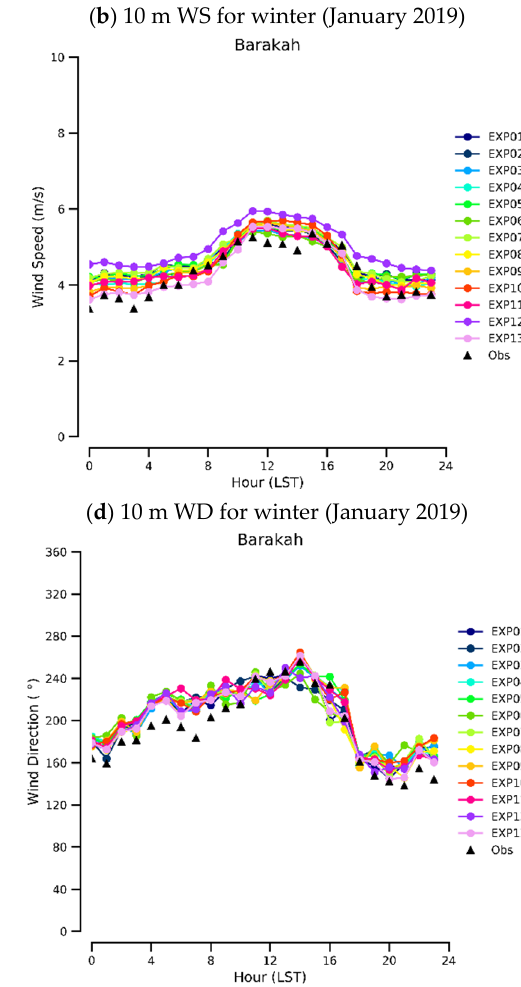
Figure 8. Mean diurnal variations for 10-m WS and WD at Barakah station calculated for June and January 2019. The curve in black color shows the observation, while the others depict the different model simulations. Table 4. Statistical metrics calculated for June 2019 hourly data at Barakah station.